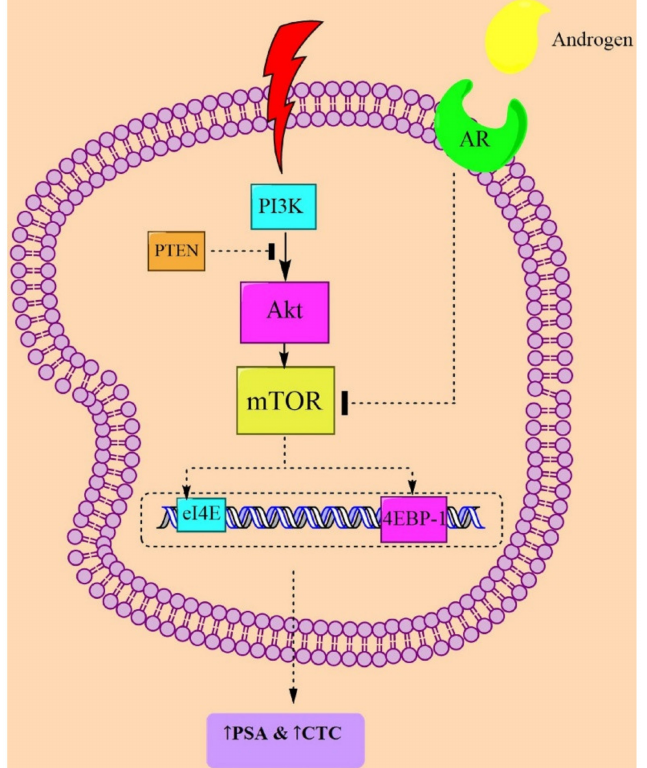
Figure 1. Possible mechanisms from clinical studies targeting mTOR in PC pathogenesis. Abbreviations: AR = androgen receptor; CTC = circulating tumor cell; mTOR = mammalian target of rapamycin; PTEN = phosphatase and tensin homolog; 4EBP1 = 4E-binding protein 1; PSA = prostate-specific anti- gen; and PI3K = phosphoinositide